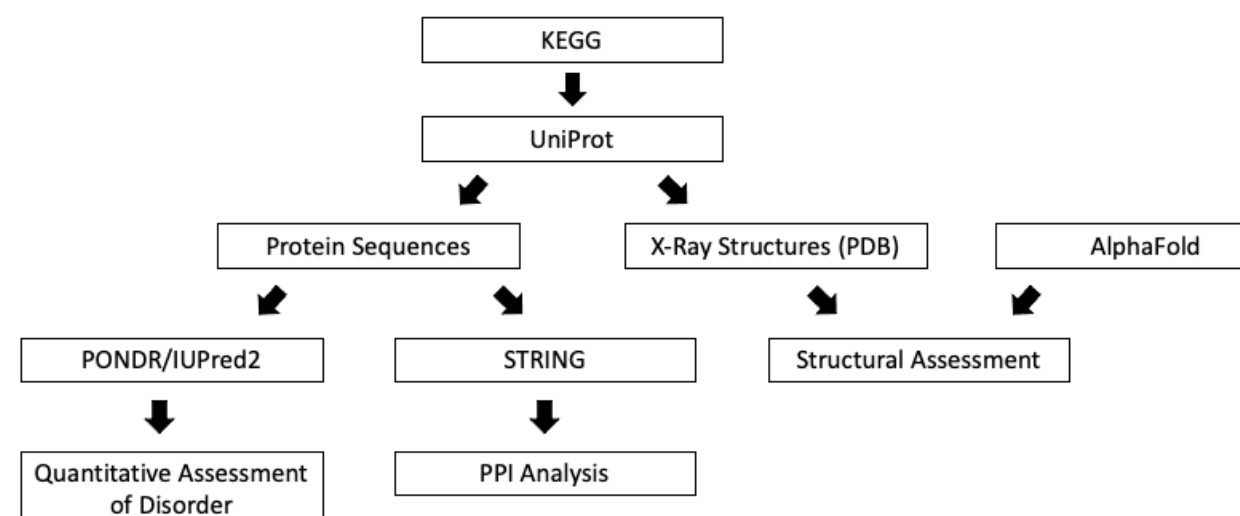
Figure 1. A flowchart of structural analysis of driver genes mutations in conjunctival melanoma. KEGG; Kyoto Encyclopedia of Genes and Genomes. UniProt; Universal Protein resource. PONDR, Predictor of Natural Disordered Regions. IUPred2; web server for the prediction of intrinsically unstructured regions of proteins. STRING; Search Tool for the Retrieval of Interacting Genes. PPI; Protein-Protein Interaction. PDB; Protein Data Bank. AlphaFold; Artificial Intelligence Program for Protein Structure Prediction.